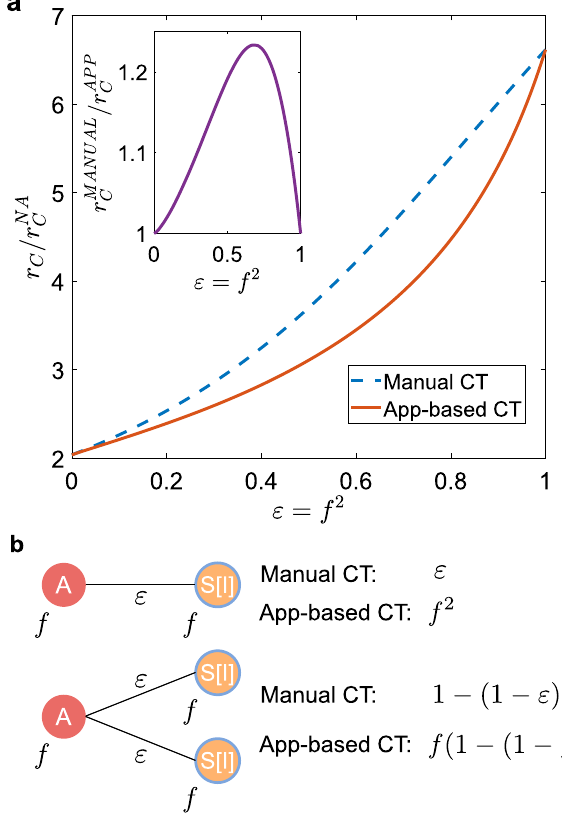
Fig. 2 Stochastic vs. prearranged sampling in contact tracing. a Plot, as a function of ϵ = f 2 , of the ratio between the epidemic threshold r C in the presence of CT protocols and the epidemic threshold of the non-adaptive case r NA . In the inset we plot the ratio between the epidemic threshold of the C manual CT r MANUAL